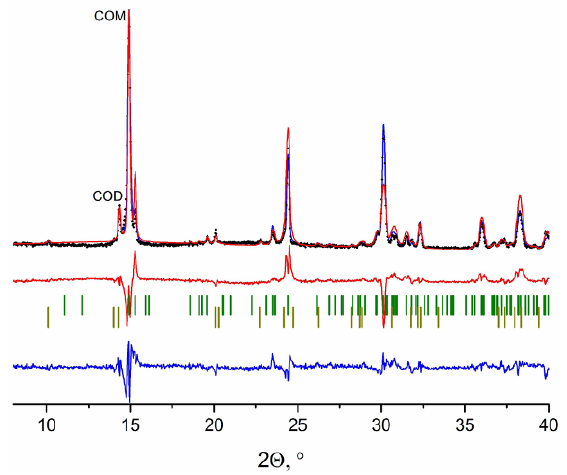
Figure 2. PXRD profile fitting of two-phase (black circles – experimental PXRD profile, Whewellite calculated diffraction lines positions – green marks and Weddellite – brown marks) sample 14 without applying a preferential orientation (red line) and with a preferential orientation applied for Whewellite phase in [1 0 0] crystallographic direction (blue line) with the corresponding differential curves (red and blue lines on the bottom). COM (1 0 0) at 14.93° diffraction line for Whewellite phase and COD is (2 0 0) at 14.36° 2 Θ diffraction line for Weddelite were used for single-line quantitative